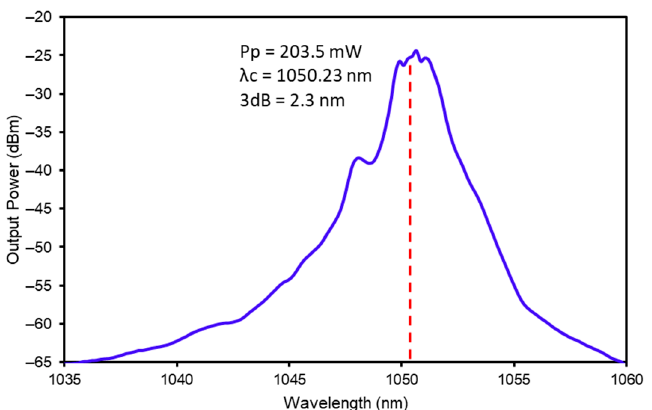
Figure 4. Optical spectrum of the mode-locked YDFL at pump power of 203.5 mW, centered at 1050.23 nm.